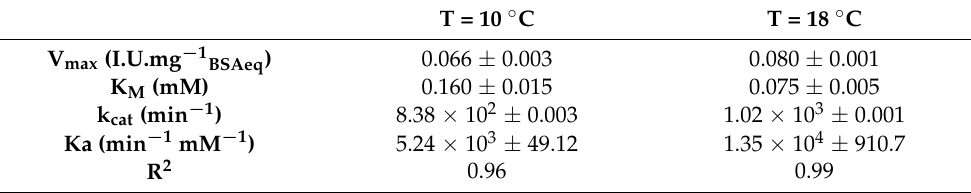
Figure 1. Kinetic curves of protease tested at two different temperatures: 10 °C ( ▲ , cold settling prior to AF) and 18 °C ( ● , AF). Assay was performed in model wine-must (tartaric buffer 0.3 M, pH Table 2. Kinetic parameters of protease tested at two different temperatures: 10 ◦ C (cold settling prior to AF) and 18 ◦ C (AF). Assay was performed in model wine must (tartaric buffer 0.3 M, pH 3.2) added with the synthetic chromogenic substrate Z-Gly-Pro-pNA (0–1 mM).